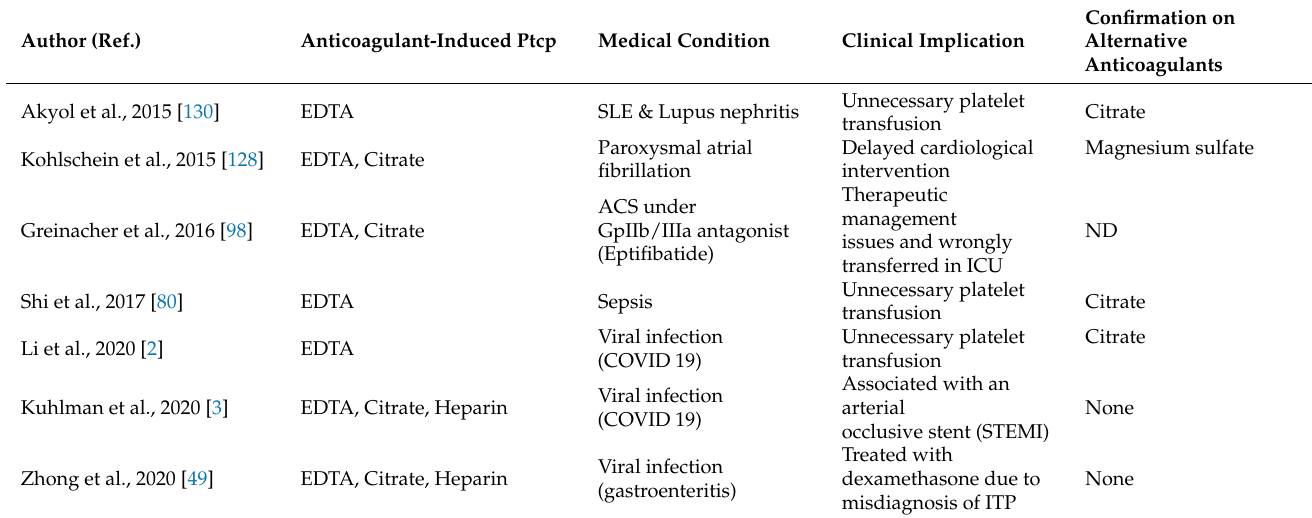
Table 1. PTCPs with clinical impact reported in the literature since